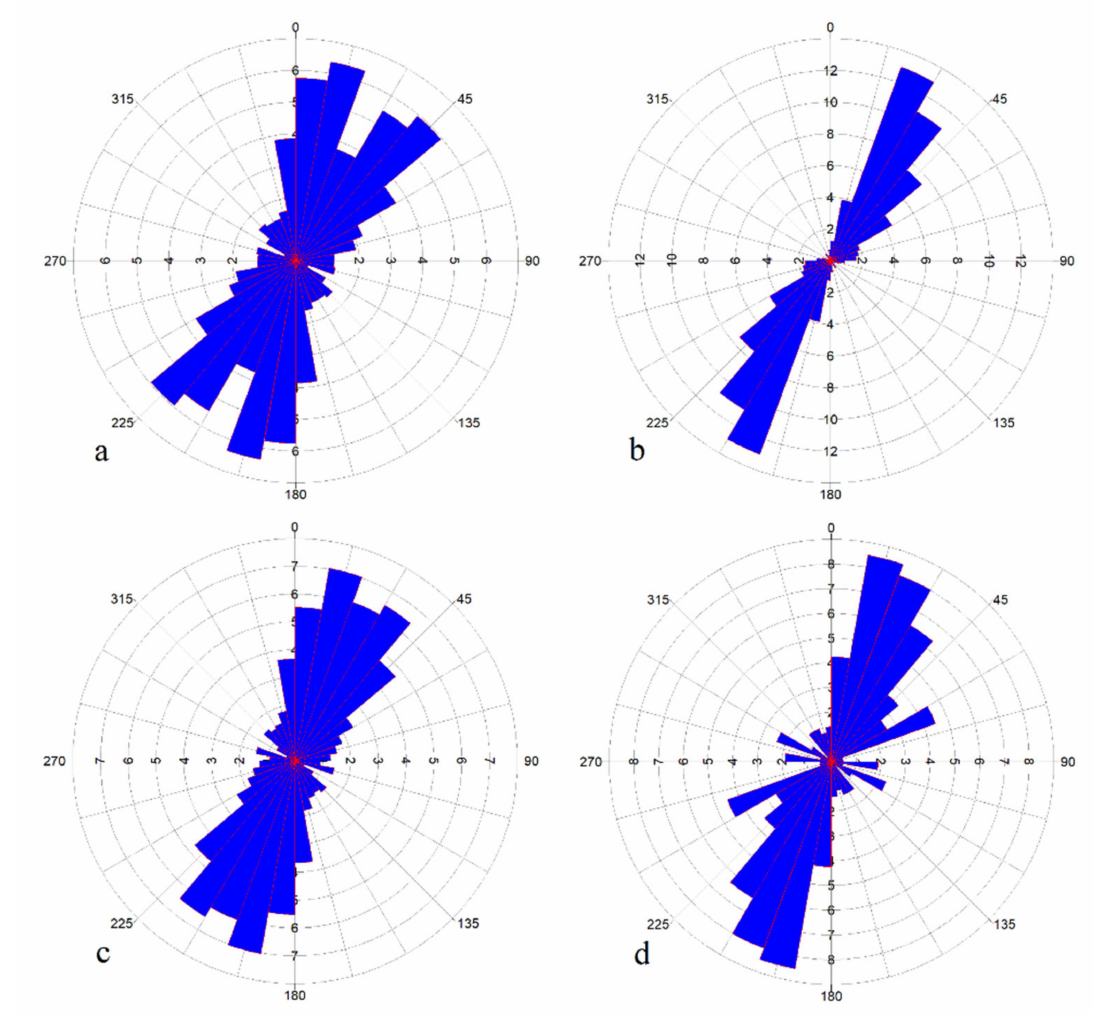
Figure 8. Orientations of lineaments of ( a ) zone I and ( c ) zone II compared to the faults of ( b ) zone I and ( d ) zone